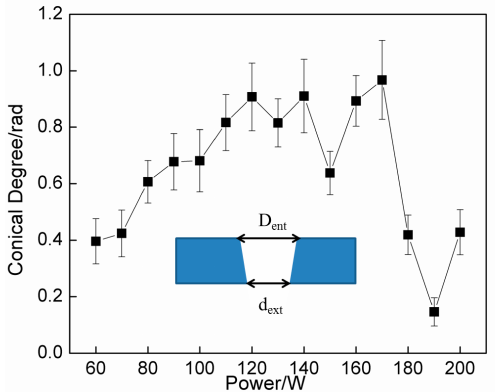
Figure 6. Variation of conical degrees and S dev of entrance and exit circles with laser